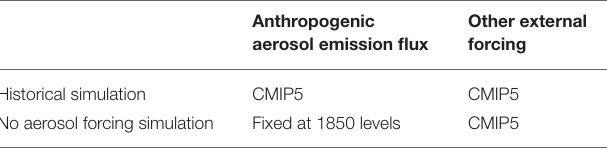
TABLE 2 | Experimental design for historical simulation and no aerosol forcing